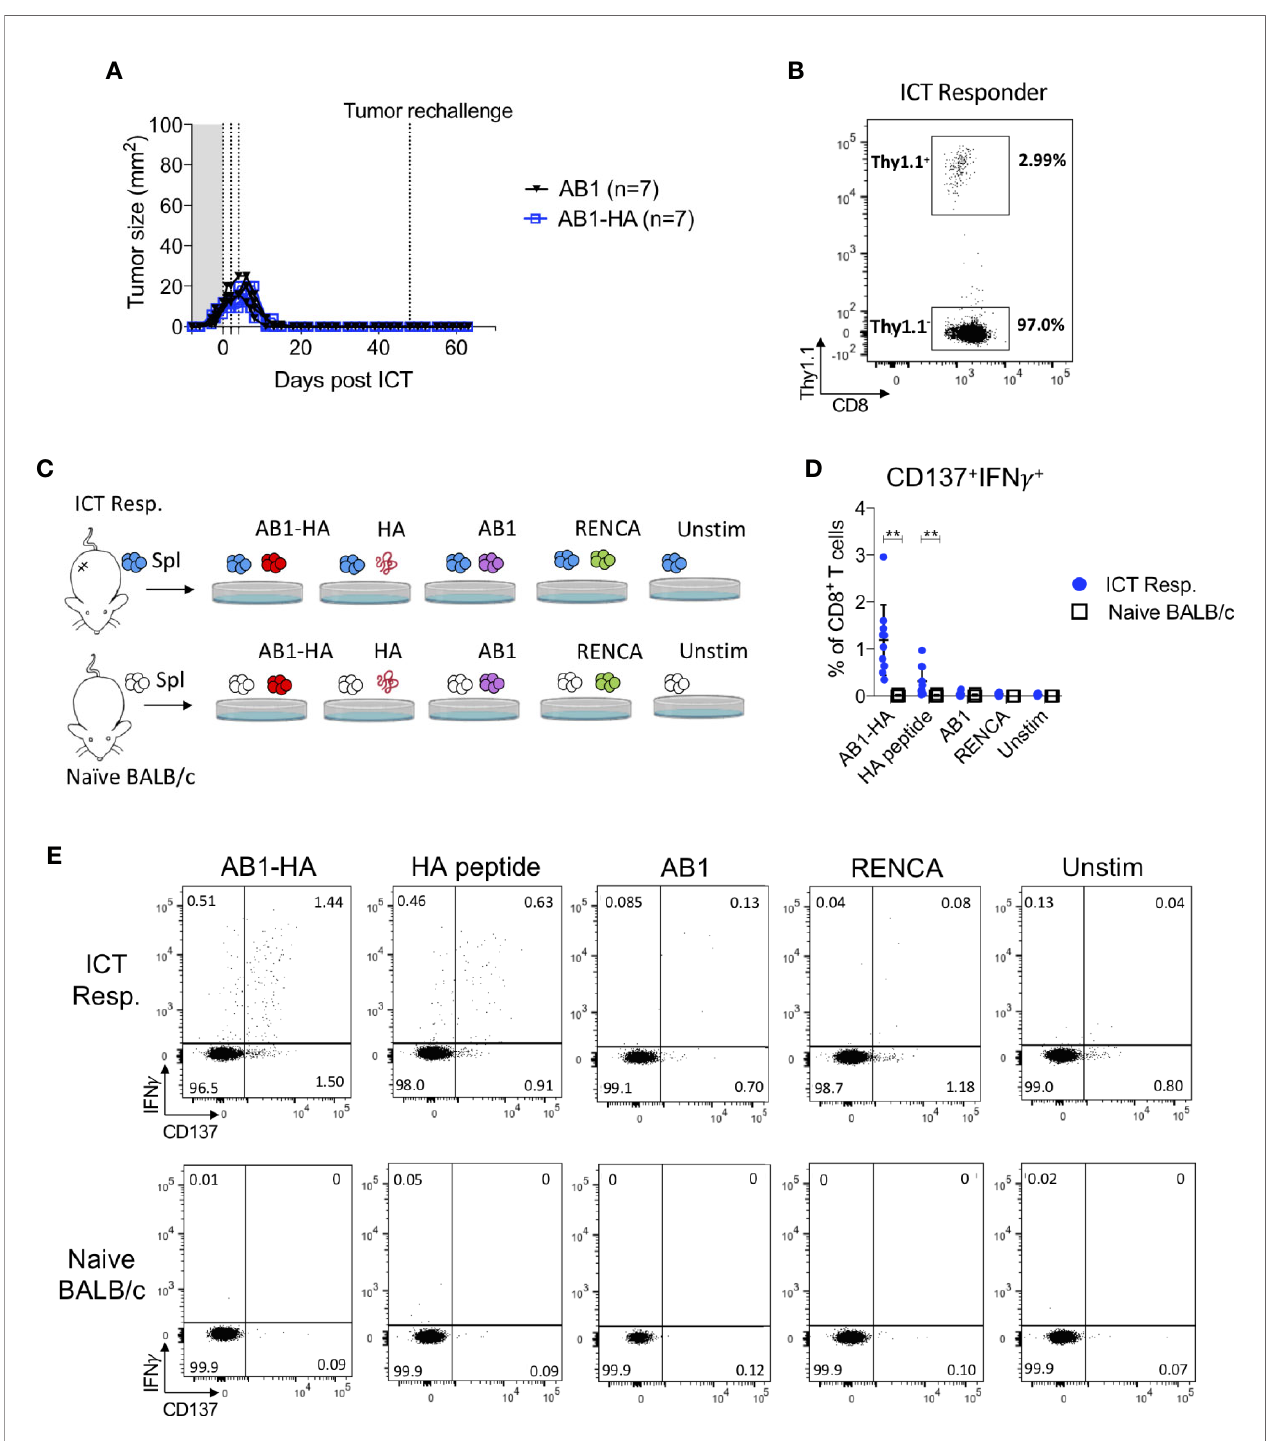
FIGURE 5 | ICT responders develop a tumor antigen-speci fi c memory T cell response. (A) Representative tumor growth curves of ICT responders re-challenged with AB1-HA or AB1 tumor cells 30 days after the primary tumor regressed to 0 mm 2 . (B) Representative FACs plot of CD8 + Thy1.1 + T cells from splenocytes from an ICT responder, 15 days after AB1-HA tumor re-challenge. (C) Ex vivo co-culture setup to assess antigen-speci fi c T cell responses. Splenocytes from ICT responders or naive BALB/c mice were co-cultured with AB1-HA, AB1, RENCA tumor cells, or HA peptide. (D) Dot plots and (E) representative fl ow cytometry plots, showing percentages of CD8 + T cells that co-expressed IFN g and CD137 for each culture condition. Data shown as mean ± SD, summary of two independent experiments; ICT responders: n = 10; Naïve BALB/c: n = 4. Mann-Whitney U tests; **P ≤